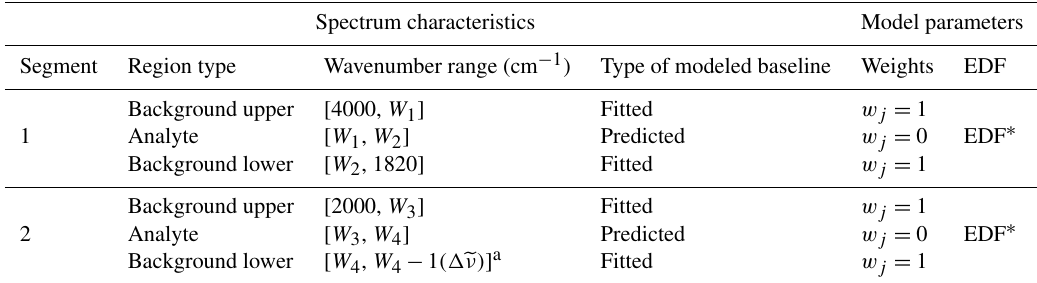
Table 3. The relationship between FT-IR spectrum features and smoothing splines parameters to model those